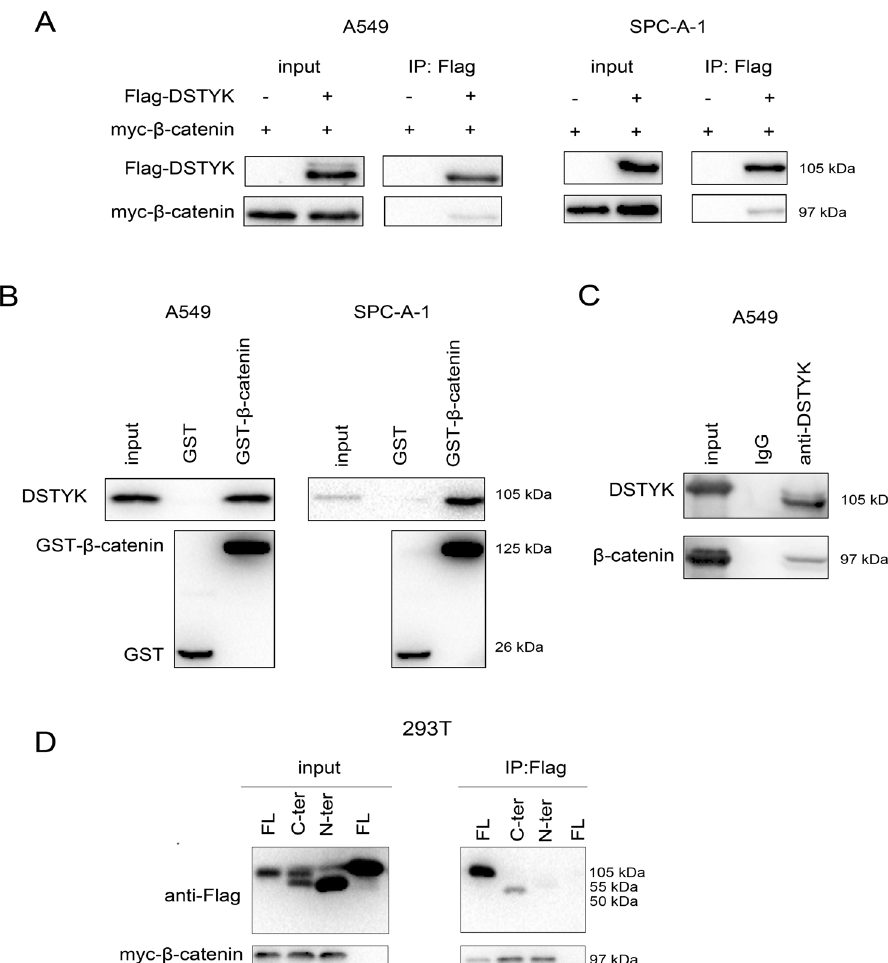
between endogenous β -catenin and the fusion protein GST-DSTYK. C The interaction between exogenously expressed Flag-DSTYK and myc- β -catenin was examined using immunoprecipitation. Cells were harvested and lysed with RIPA buffer, and anti- β -catenin antibody was added for immunoprecipitation. D An immunoprecipitation assay was performed to determine the domain of DSTYK that binds myc- β -catenin. N-ter the N-terminus of DSTYK (1 – 500 aa), C-ter the C-terminus of DSTYK (501 – 929 aa), FL the full length of